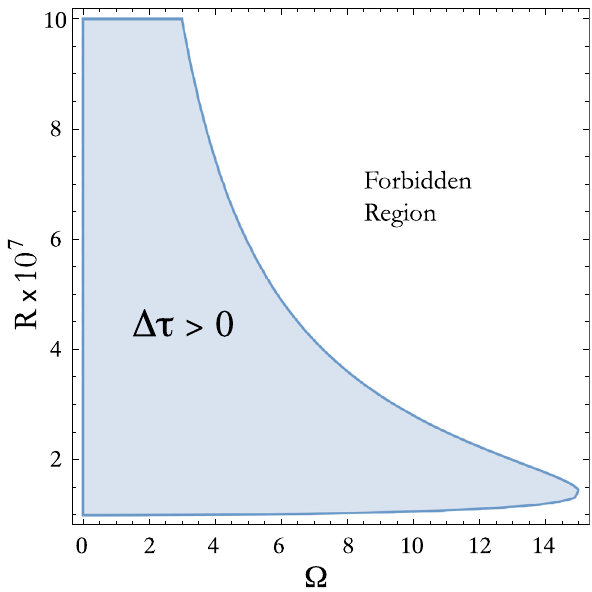
Fig. 9 Region plot for the condition Δτ > 0 for the separation dis- tances between the source and the interferometer, R and the angular velocityofthecomovingobserver, Ω ,for λ = 2 × 10 10 and Q = 2 × 10 7 (all values are in arbitrary length